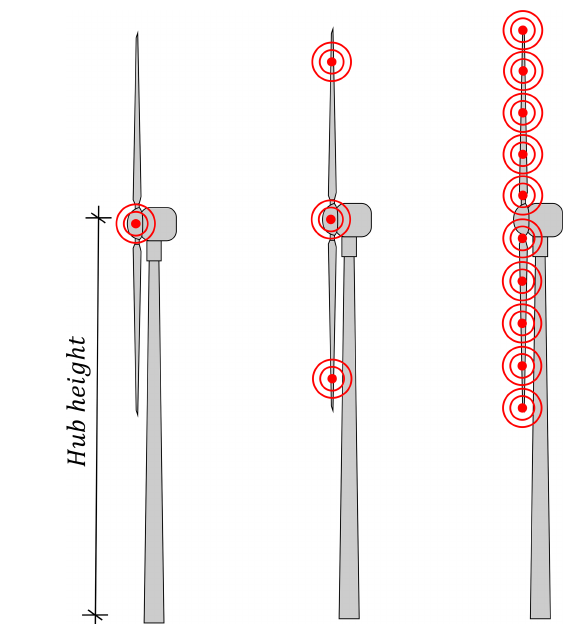
Figure 11. Schematic illustration of the setup with 1, 3 and 10 point sources.